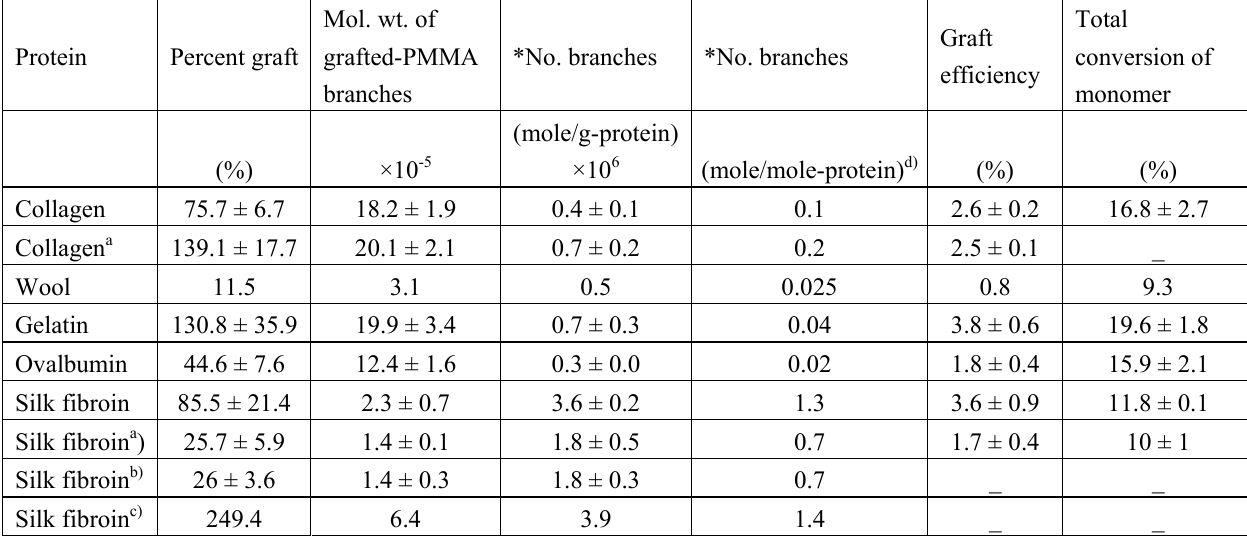
Table 3. Tri- n -butylborane-initiated graft copolymerization of methyl methacrylates with hydrated rat-tail collagen, wool, gelatin and silk